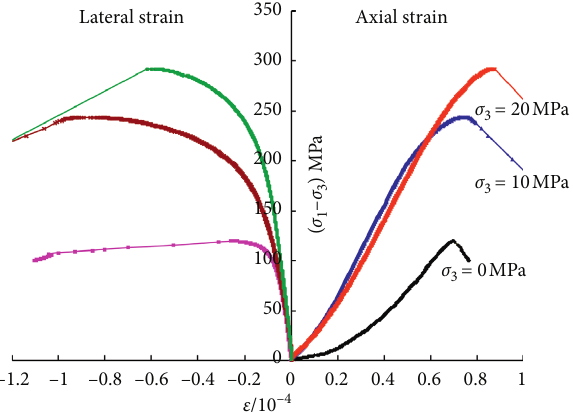
1 – σ 3 )-strain ( ε ) curve for